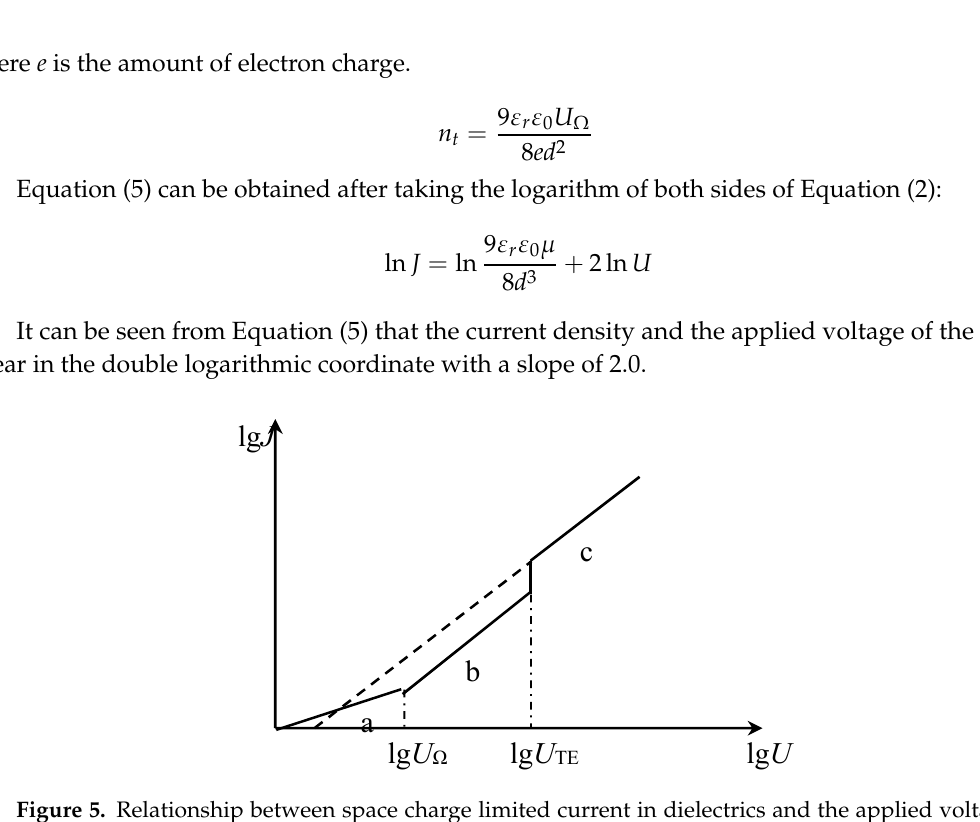
Figure 5. Relationship between space charge limited current in dielectrics and the applied voltage. a-region: linear region, i.e., ohmic conduction current region; b-region: Calder’s law region of space charge limited current when trapped; c-region: Calder’s Law region with trap filling or without